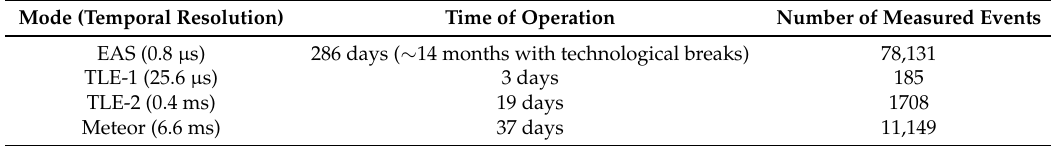
Table 1. The number of events and time of operation of the TUS detector in different